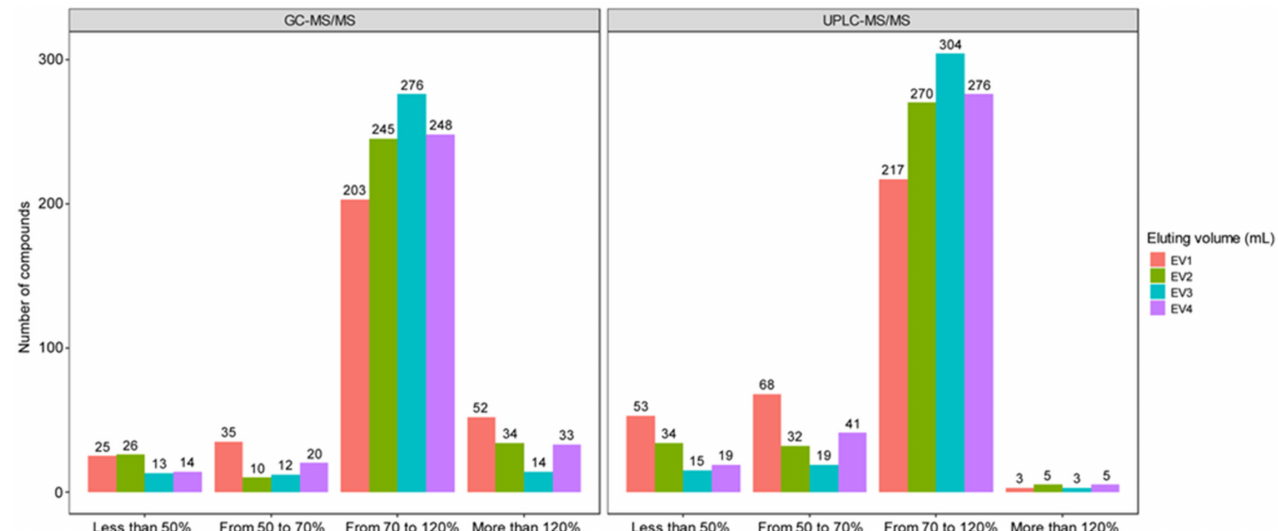
Figure 3. Comparision of the number of compounds obtained at different recoveries by using different elution volume (UPLC-MS/MS: 341 compounds, GC-MS/MS: 315 compounds). EV1: 10 mL, EV2: 15 mL, EV3: 20 mL, and EV4: 25 mL.